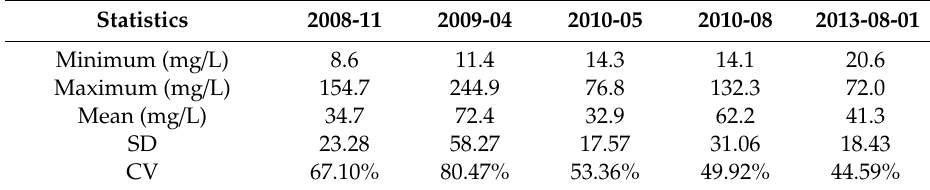
Table 2. Statistics describing the variation of TSM concentration (TSM, mg / L), SD is the standard deviation (mg / L), and CV is the coe ffi cient of variation